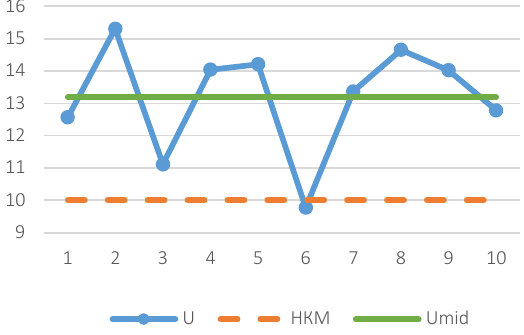
Figure 2. The Shewhart chart for the H3 (regulatory capital to total assets) evolution